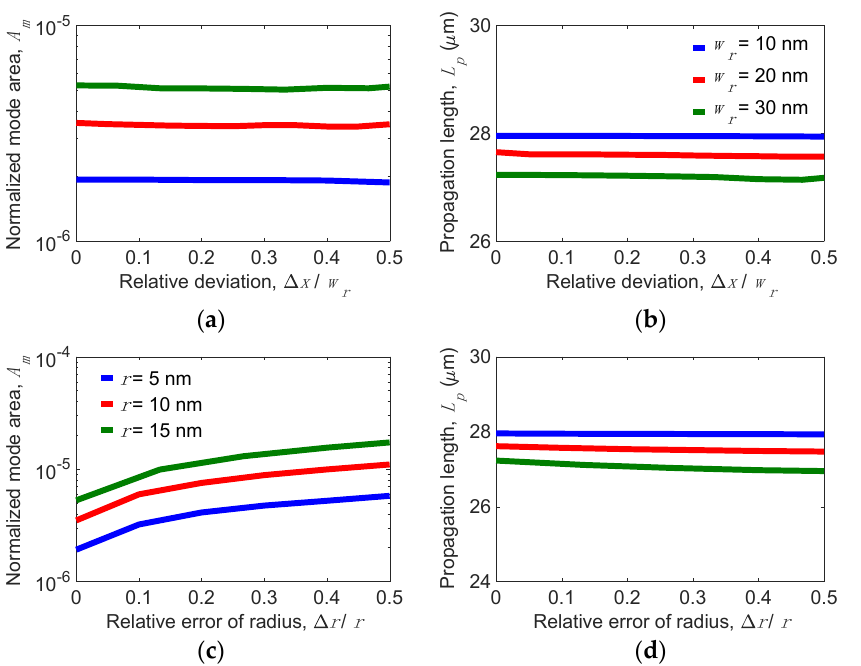
Figure 10. Dynamics of ( a ) normalized mode area, A m , and ( b ) propagation length, L p , versus the relative fabrication error of the width of the Si nano-rib ( Δ x / w r ) for different w r values; ( c ) A m and ( d ) L p versus the relative fabrication error of the radius of the curvature of the Si nano-rib ( Δ r / r ) for different r values when h r = 30 nm, t Si = 5 nm , t d = 5 nm, and w g = 200 nm.